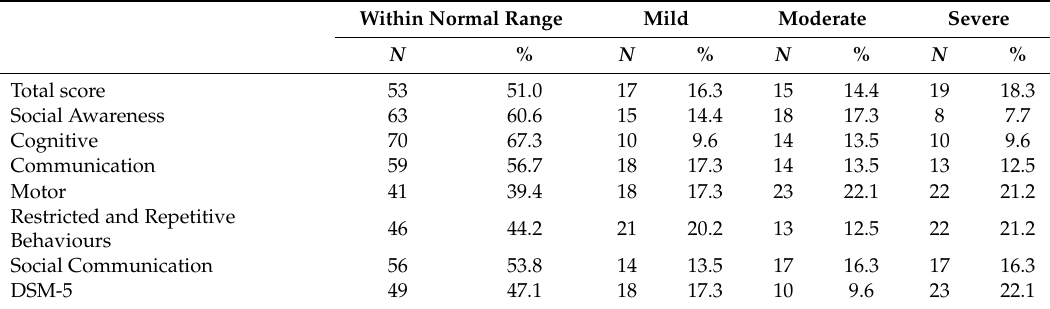
Table 2. Proportion of sample falling within each range on the SRS-2 total and subscales. Within Normal